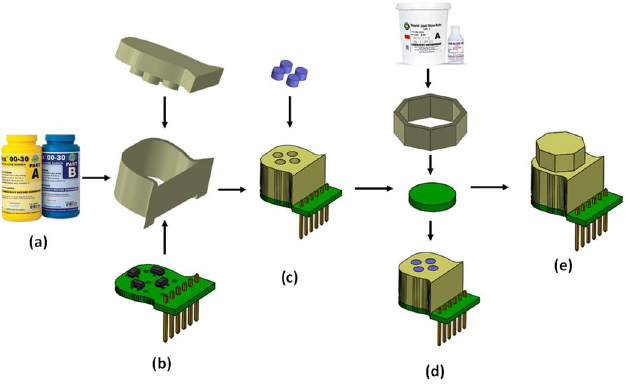
Figure 3. ( a ) Ecoflex 00-30 elastomer; ( b ) assembled PCB and 3D printed molds; ( c ) magnets and cured elastomer; ( d ) RTV-528 elastomer, 3D printed mold, fiber sheet and embedded magnets in elastomer; ( e ) final assembled sensor.